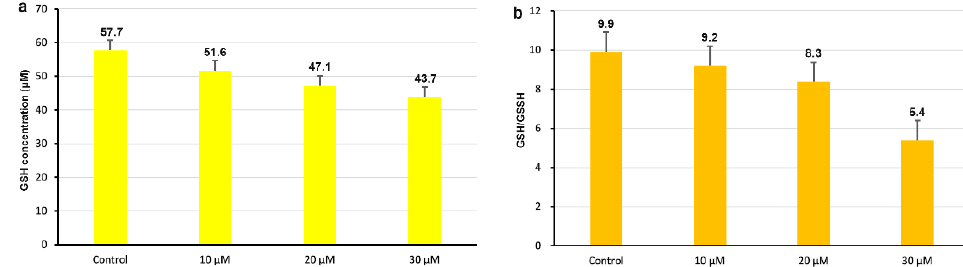
Figure 8. ( a ) Analysis of intracellular GSH content after 24 h exposure of HeLa to different concen- tration of compound 3a . ( b ) Quantification of the ratio of GSH/GSSG in HeLa cells. tion of compound 3a . ( b ) Quantification of the ratio of GSH/GSSG in HeLa